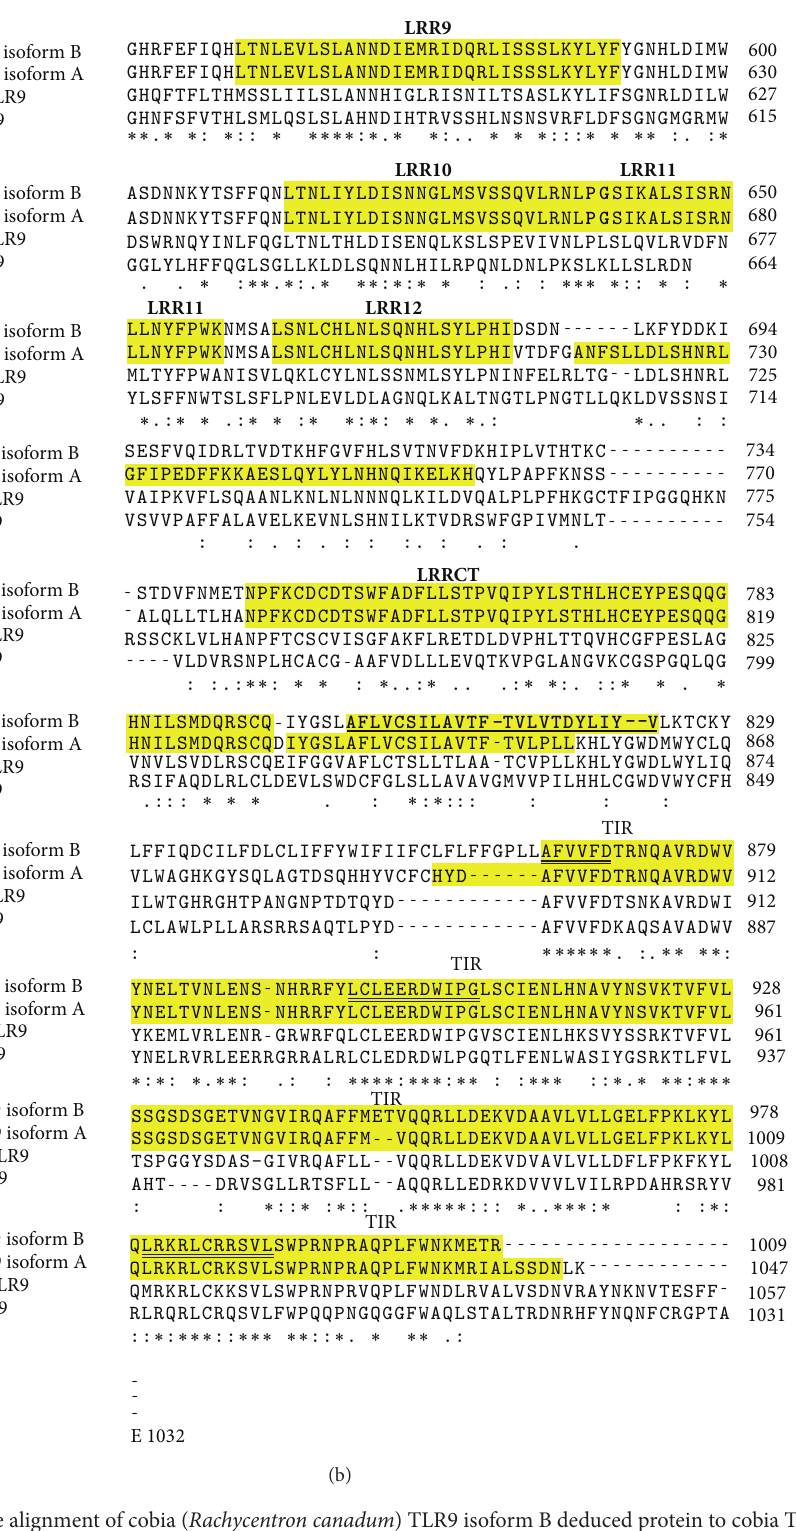
Figure 1: Amino acid sequence alignment of cobia ( Rachycentron canadum ) TLR9 isoform B deduced protein to cobia TLR9 ( Rachycentron canadum , AGD79973.2), zebrafish TLR9 ( Danio rerio , NP 001124066), and mouse TLR9 ( Mus musculus , NP 112455.2). LRR , LRRTYP , and LRRCT domains are indicated with bold letters shaded with yellow accent; transmembrane domains are bold and underlined. CXXC motifs are indicated by black box; highly conserved motifs in TIR domains are double underlined. - - - - Sequence gaps, ∗ identical residues, : conserved substitution, and . semiconserved